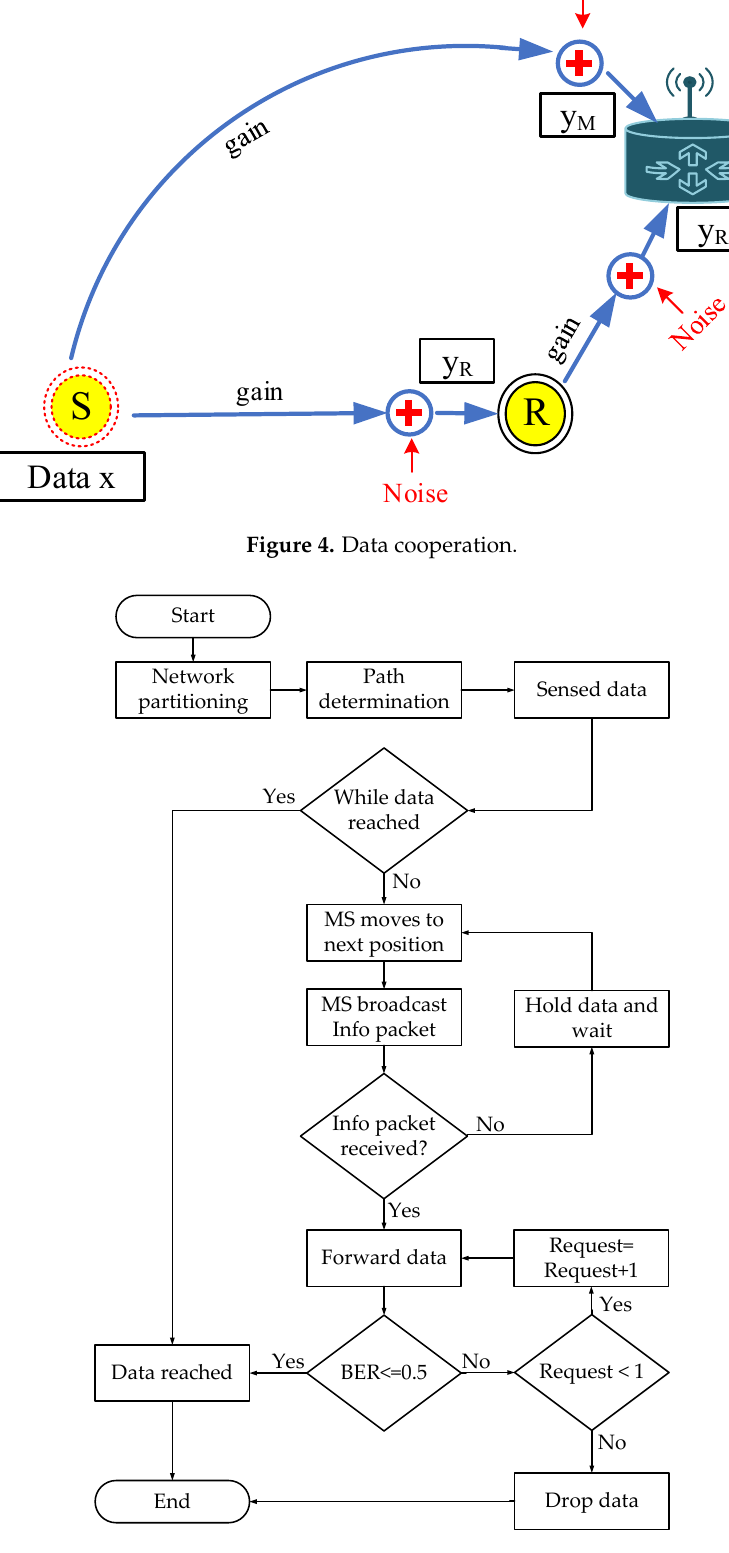
Figure 5. Flowchart for the cooperative sink mobility for reliable and persistence operation (CoSiM-RPO)